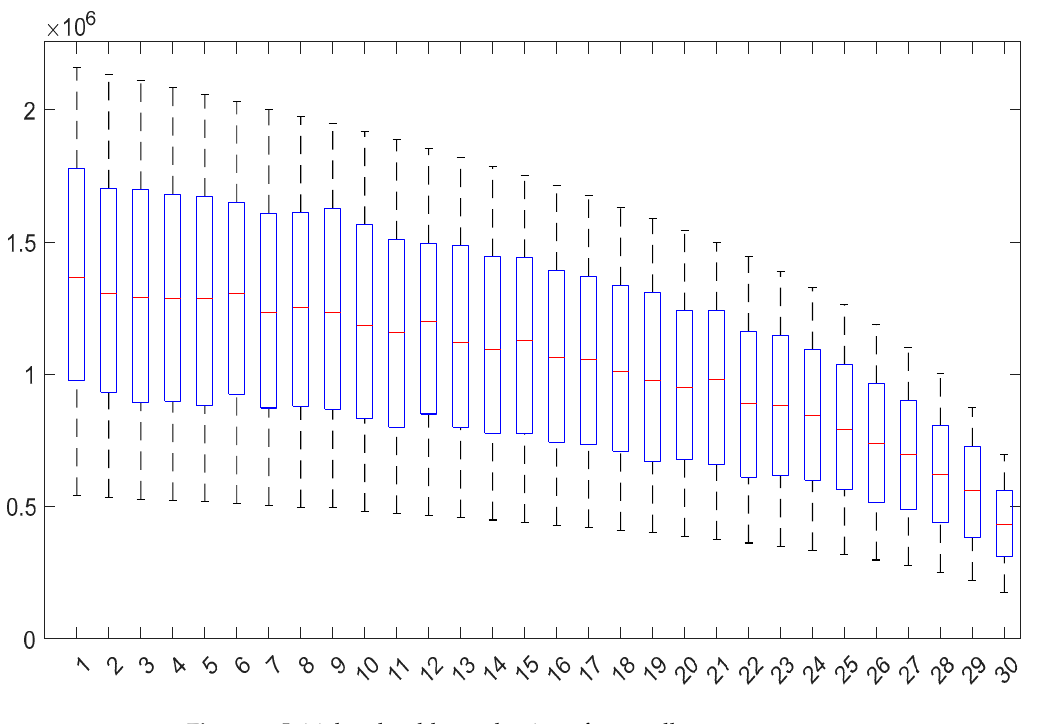
Figure 3. Initial and stable production of gas wells.